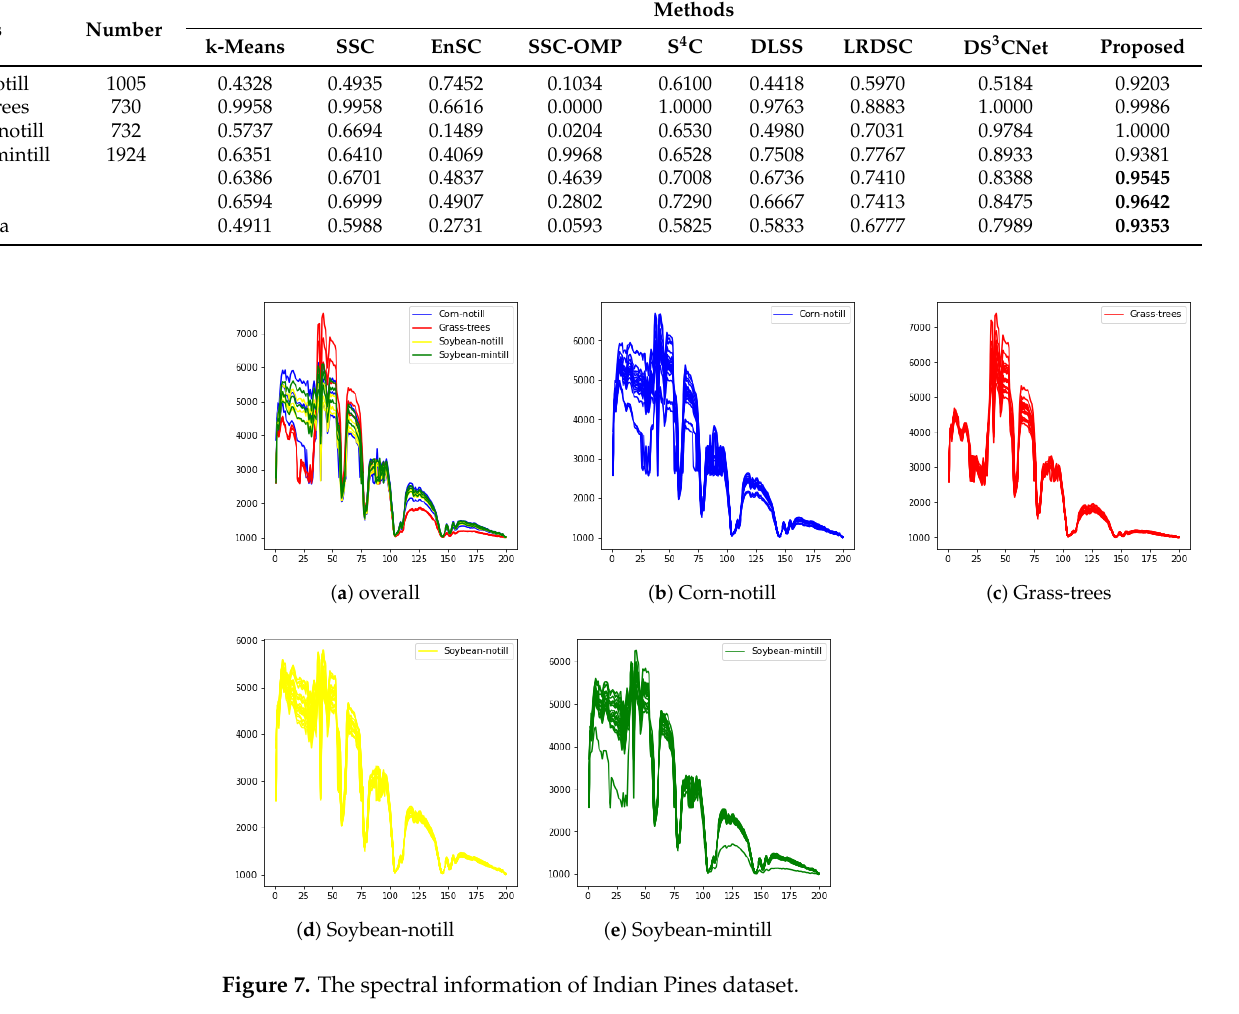
Figure 7. The spectral information of Indian Pines dataset.